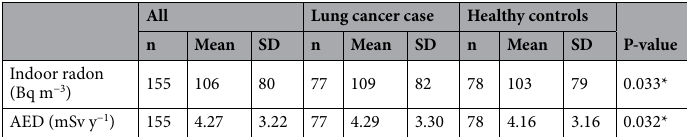
Table 4. Indoor radon concentrations (Bq m −3 ) and AED (annual effective dose) of lung cancer cases and healthy controls.